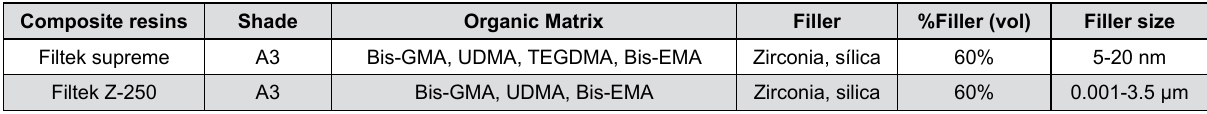
Composite resins